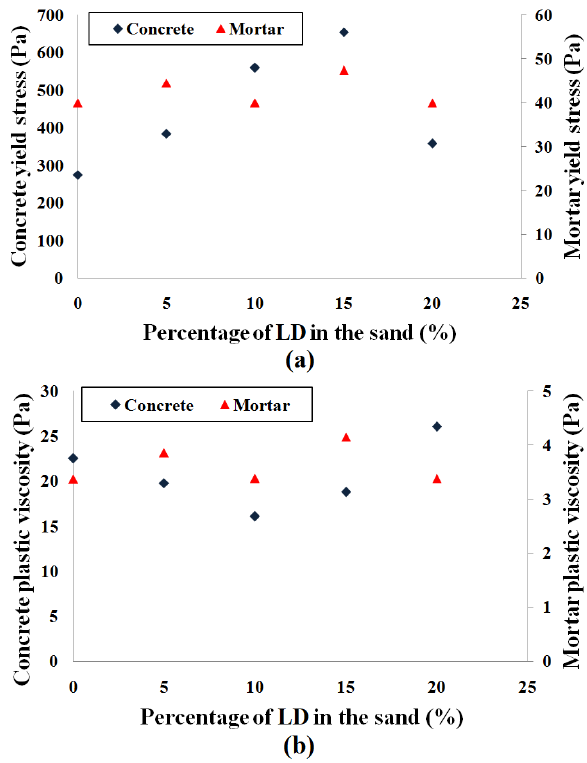
Figure 13: Correlation between (a) the yield stress and (b) the plastic viscosity of concrete and its CEM.